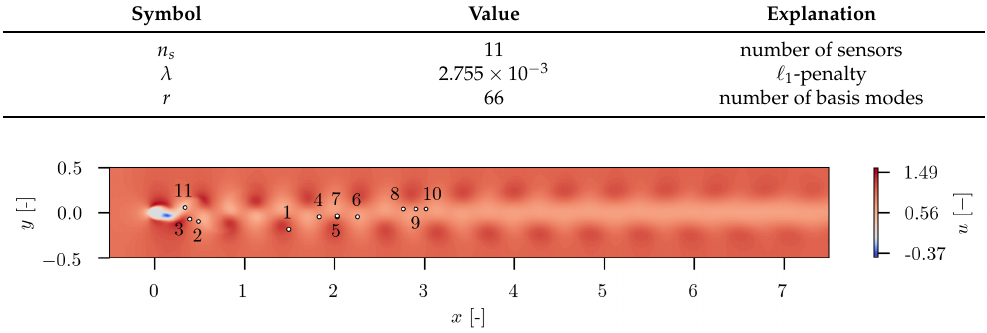
Figure 11. Sensor locations with snapshot at i t = 1500 as